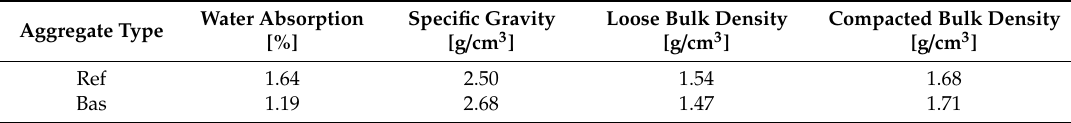
Table 1. Basic properties of natural round gravel aggregate (Ref) and crushed basalt aggregate (Bas). Aggregate Type